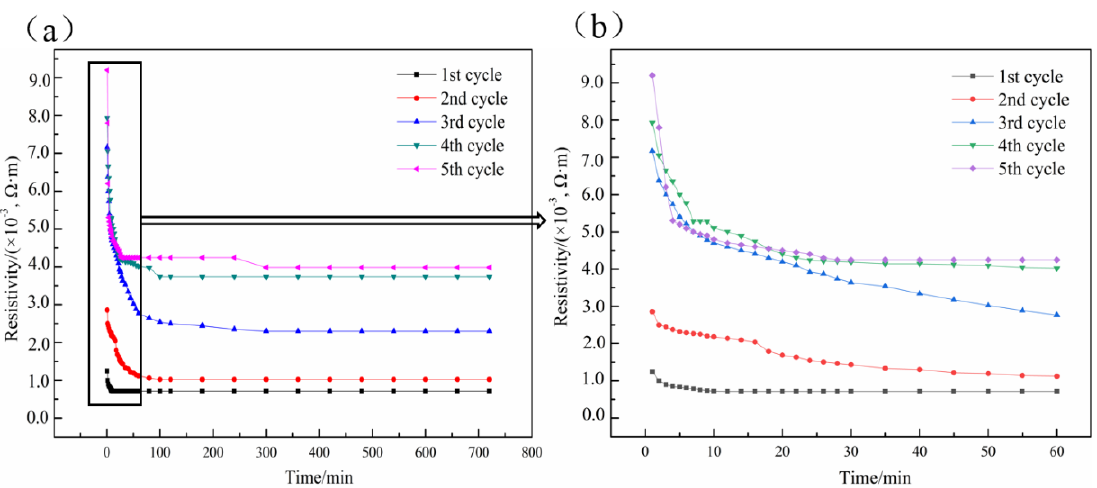
Figure 11. Cross-sectional morphology of electrical-heating coating after cyclic electricity test and EDS analysis. 3.3. Effect of Hydrogen Heat Treatment on Coating Electrical-Heating Properties Some studies [34,35] have shown that a hydrogen atmosphere can promote rutile TiO 2 to form non-stoichiometric TiO 2 (anoxia phases of titanium dioxide). The contents of non-stoichiometric TiO 2 have an important influence on the conductivity of TiO 2 coating. The higher the content of non- stoichiometric TiO 2 , the higher the conductivity of TiO 2 coating [36,37]. Figure 12 shows the temperature – time curve of the cyclic electrification test of coatings after 350 °C heat treatment. During 10 cycles of electrification, the coatings can be heated stably to above 300 °C within 30 min and kept for 11 h. Compared to coatings without heat treatment in Figure 7, it can be found that the heat- treated coating can still be heated to 324 °C after 5 cycles of electrification and 310 °C after 10 cycles of electrification, much higher than 218 °C in Figure 7. The heating temperature of heat-treated coatings remains stable from the fifth cycle. It illustrates that the hydrogen heat treatment effectively improves the heating property of TM15 coating.